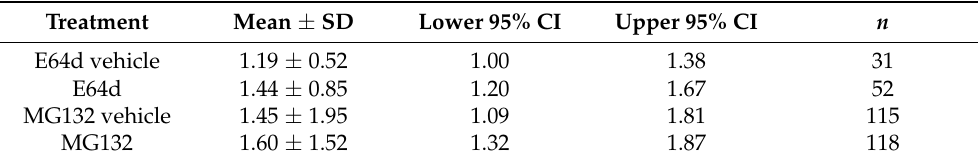
Table 2. Baseline cA-TAT proteolysis rates (arbitrary units/min) in the presence of the indicated treat- ments. Neither E64d nor MG132 significantly changed the proteolysis rate compared with their vehicle control (Welch’s unequal variances t -test; vehicles were 0.1% DMSO and 0.2% DMSO, respectively).